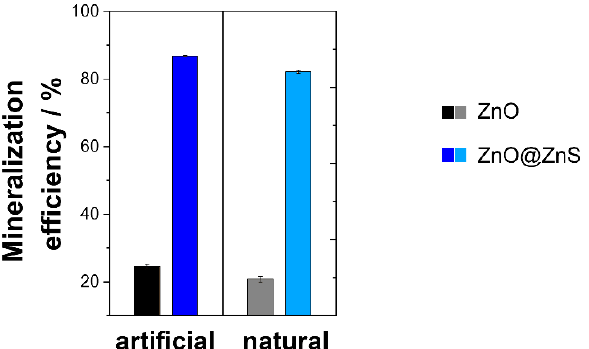
Figure 6. Mineralization efficiency of ZnO-based micro/nanoferns on a multi-pollutant solution under artificial and natural UV-filtered ( λ > 400 nm) sunlight irradiation (Irradiation time = 210 min, photocatalyst dosage = 0.4 mg mL − 1 , and T = 25.0 ± 0.1 °C).